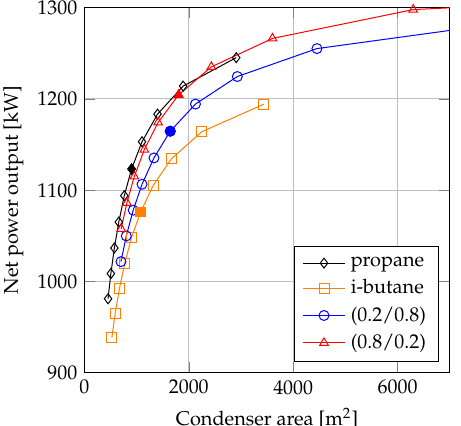
Figure 10. Net power output as a function of condenser heat transfer